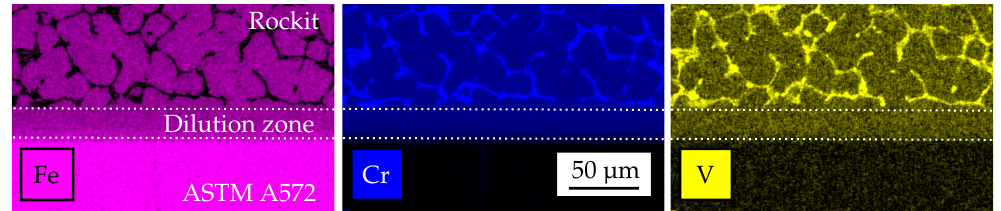
Figure 4. EDX mapping of the microstructure after